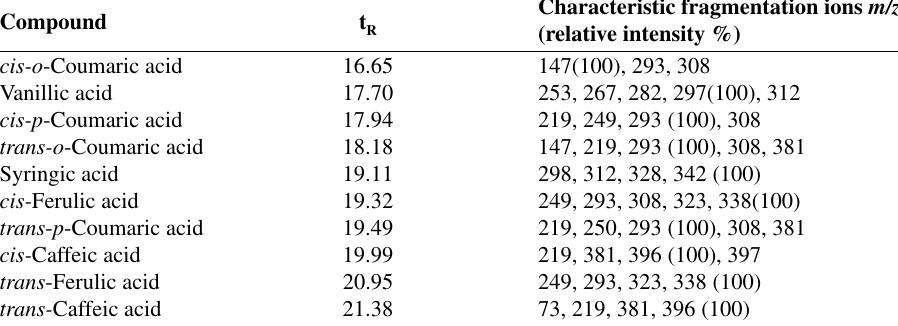
Table 3. Retention times and fragmentation parameters for trimethylsilylated PAs obtained after trimethyl- silylation using the ion-trap mass detector.